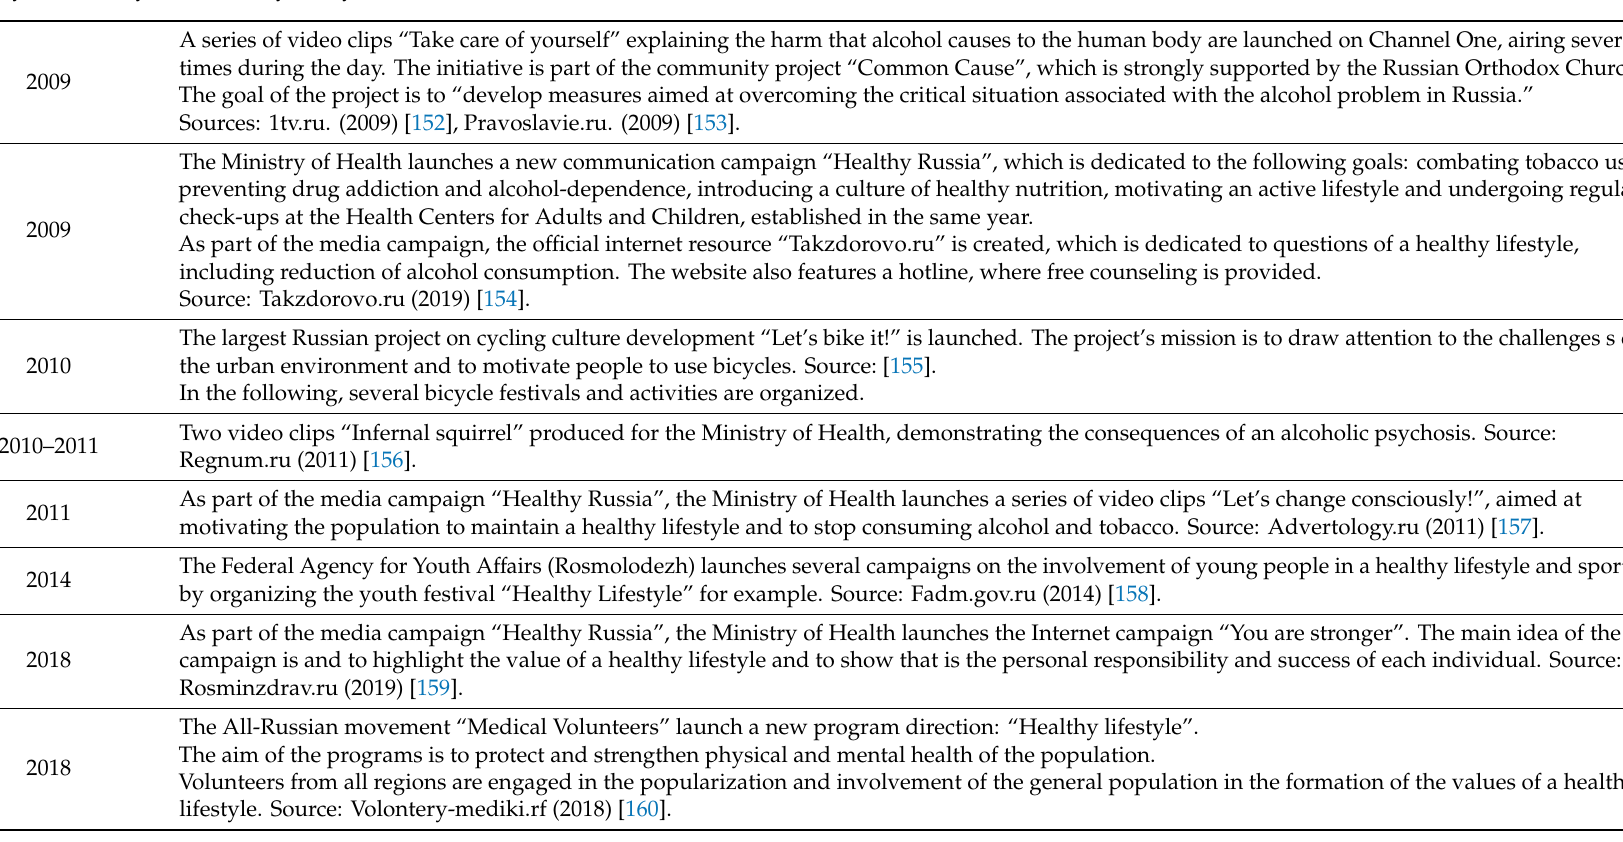
Table A3. A series of government-ordered awareness raising campaigns on the harmful use of alcohol that were launched since 2009 and campaigns that promote physical activity and a healthy